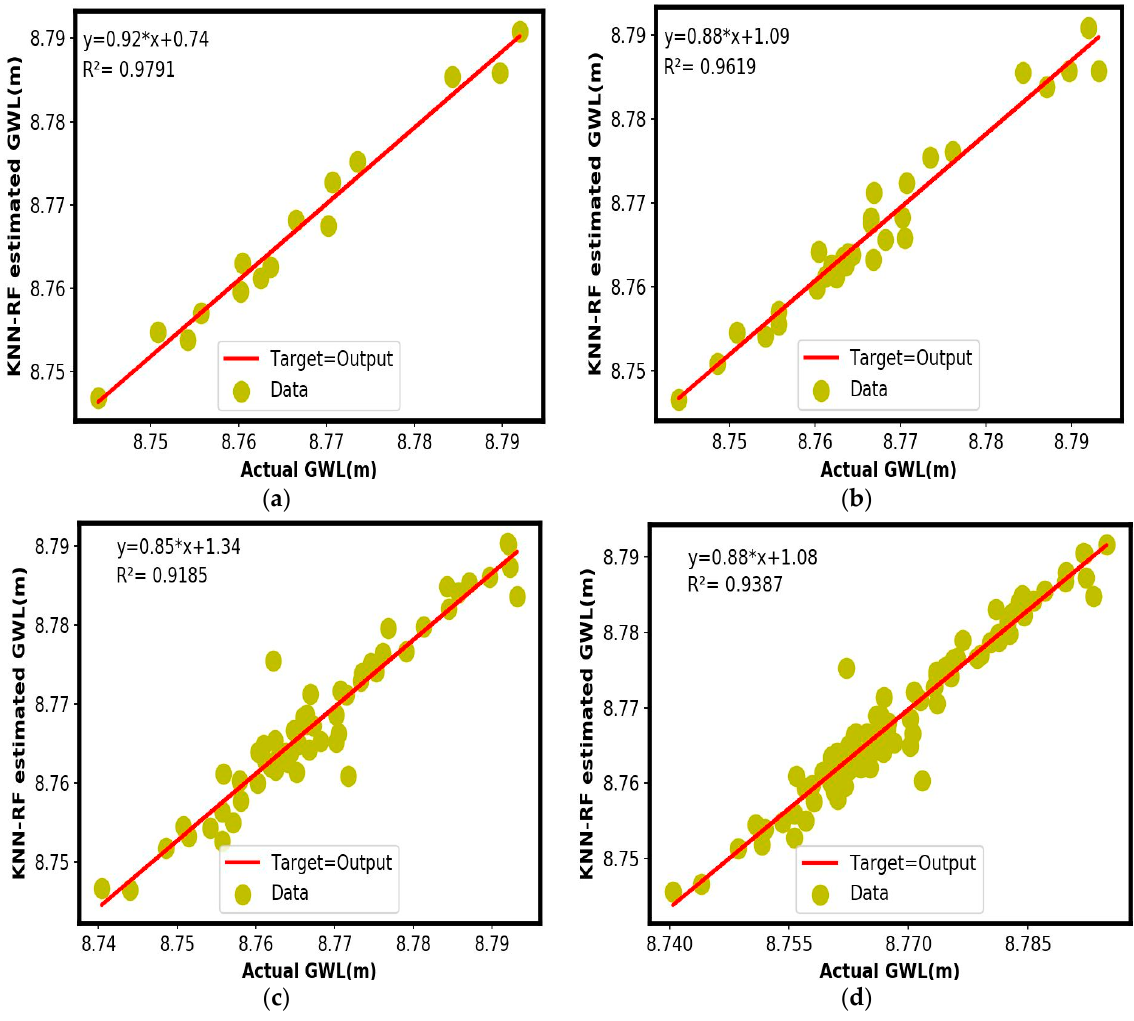
Figure 9. Assessment of the actual and the estimated groundwater levels of the optimal KNN-RF model for 15, 30, 60, and 90 days (corresponding to a – d , respectively) lead time in the testing